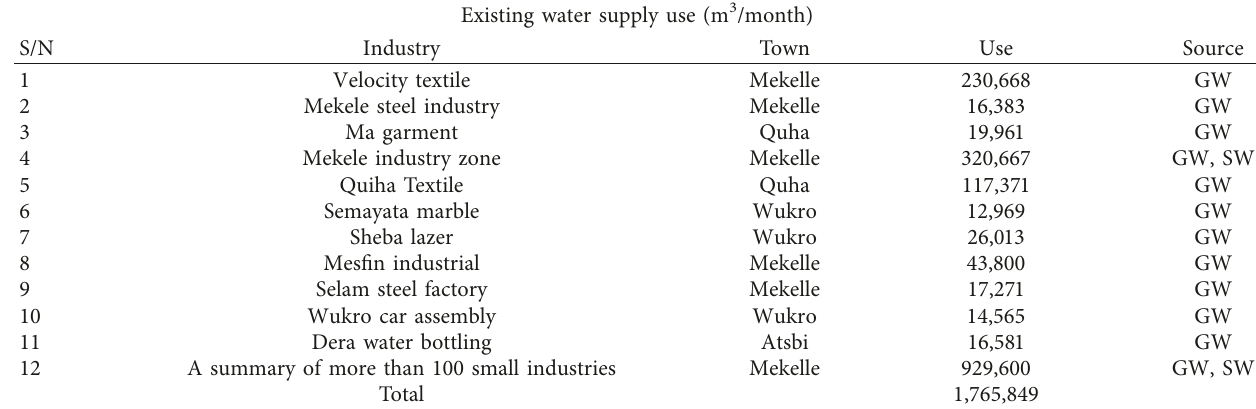
Figure 4: Water supply coverage at Woreda level and urban categories of the subbasin. Table 6: Current industrial water uses of the urban areas in the